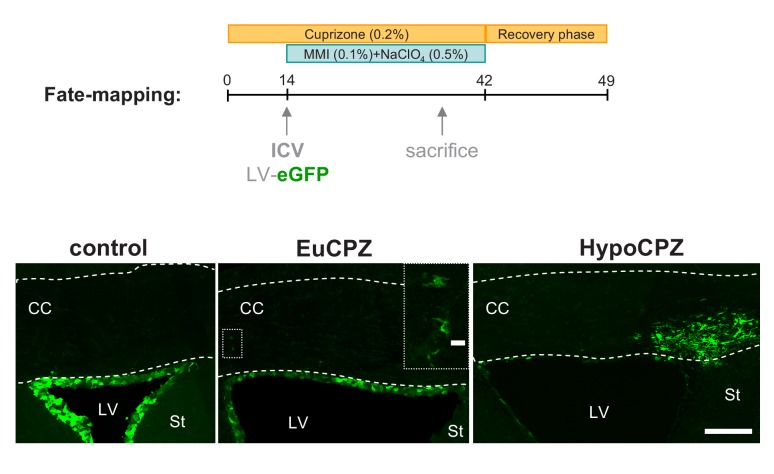
SVZ-OPCs are recruited to the corpus callosum following a demyelinating insult.Coronal sections showing GFP + cells (green) 20d after injection of CMV-eGFP-expressing lentiviral particles into the adult SVZ. GFP + cells are mainly confined to the SVZ of CTL (n = 3) and EuCPZ (n = 3) mice. Few GFP+ cells displaying oligodendrocyte morphologies can be observed in the corpus callosum of EuCPZ mice (see highlight, scale bar 10 µm). In contrast, we observed large numbers of GFP + cells in the corpus callosum of HypoCPZ (n = 3) mice, just above the lateral ventricle. CC = corpus callosum, St = striatum, LV = lateral ventricle. Scale bar: 50µ.